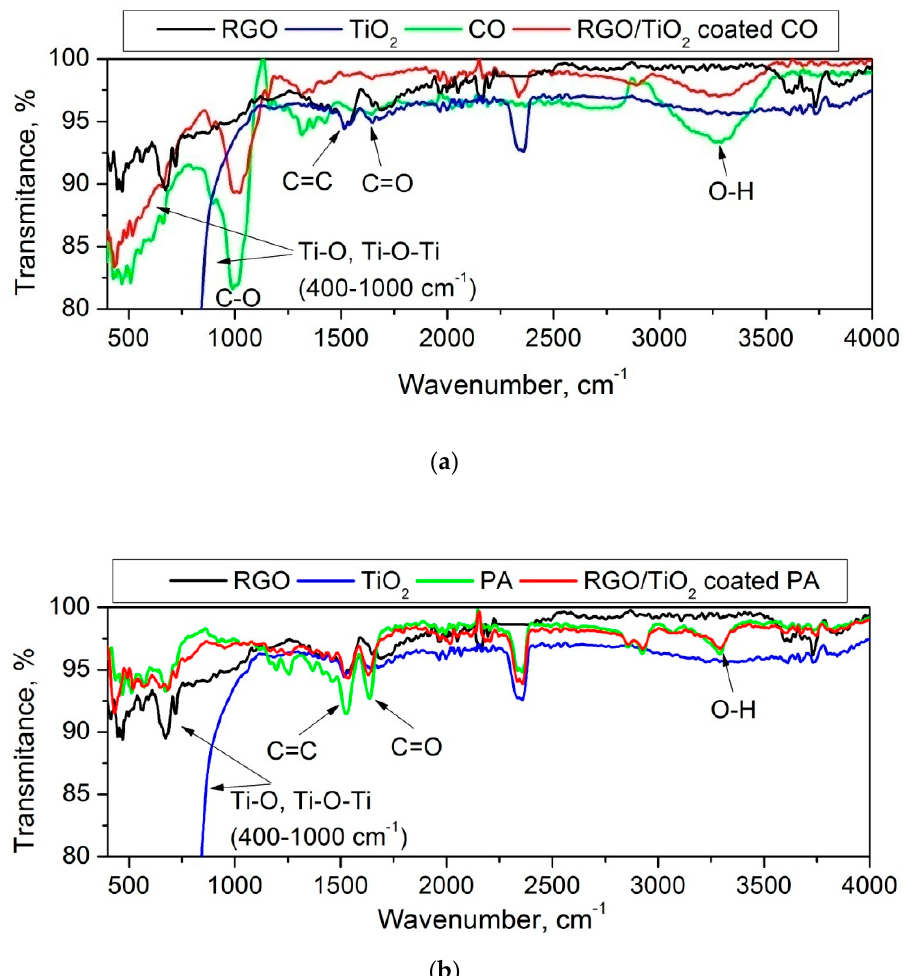
Figure 7. FTIR spectra of modifiers, raw and RGO / TiO 2 coated CO ( a ) and RGO / TiO 2 coated PA fabrics ( b